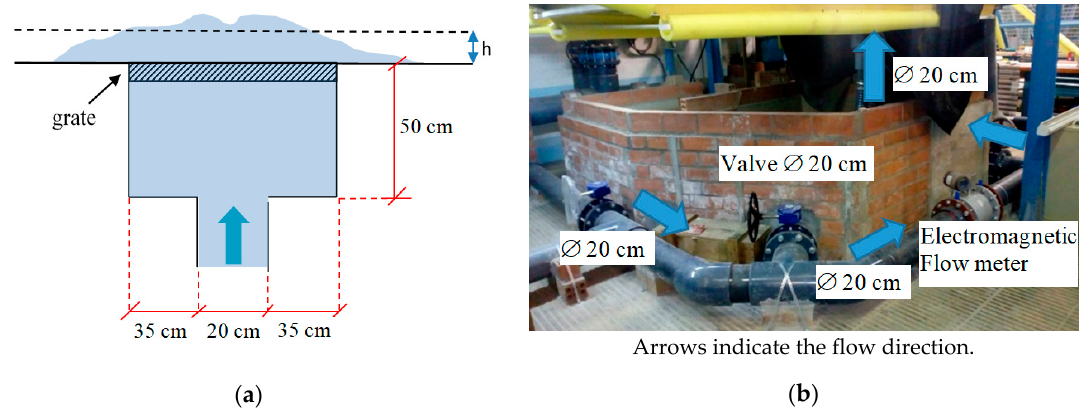
Arrows indicate the flow direction. Figure 2. ( a ) Box below the grate inlet and hydraulic pipes system; ( b ) hydraulic pipe system.